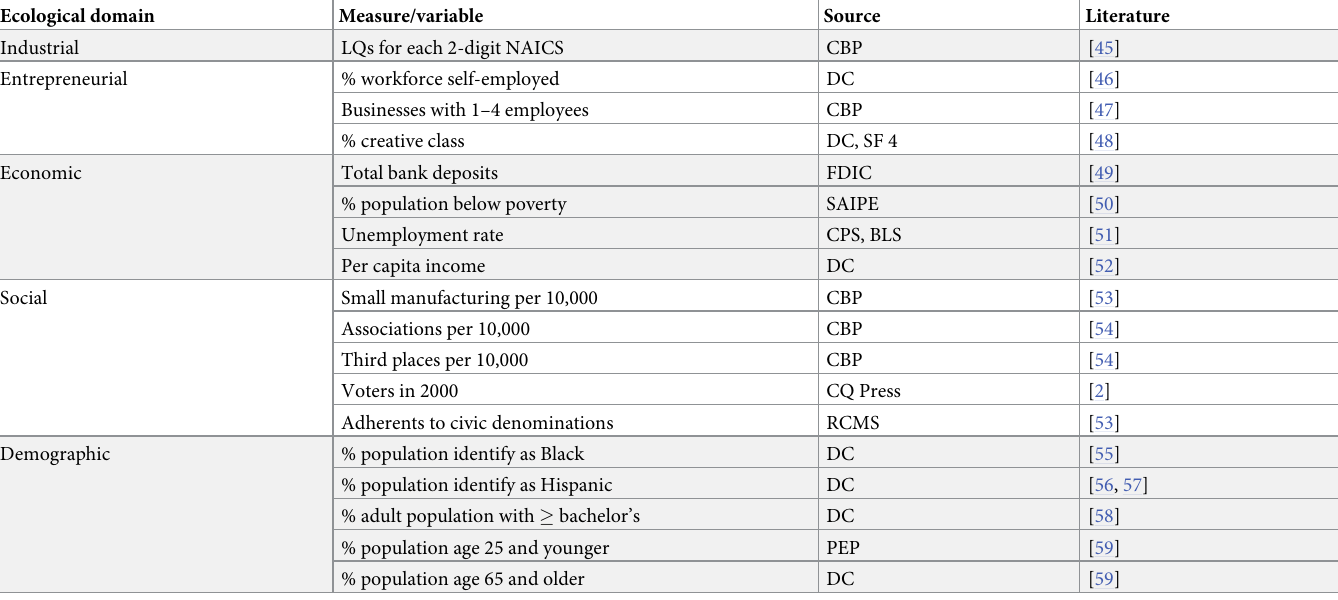
Table 1. Data summary and